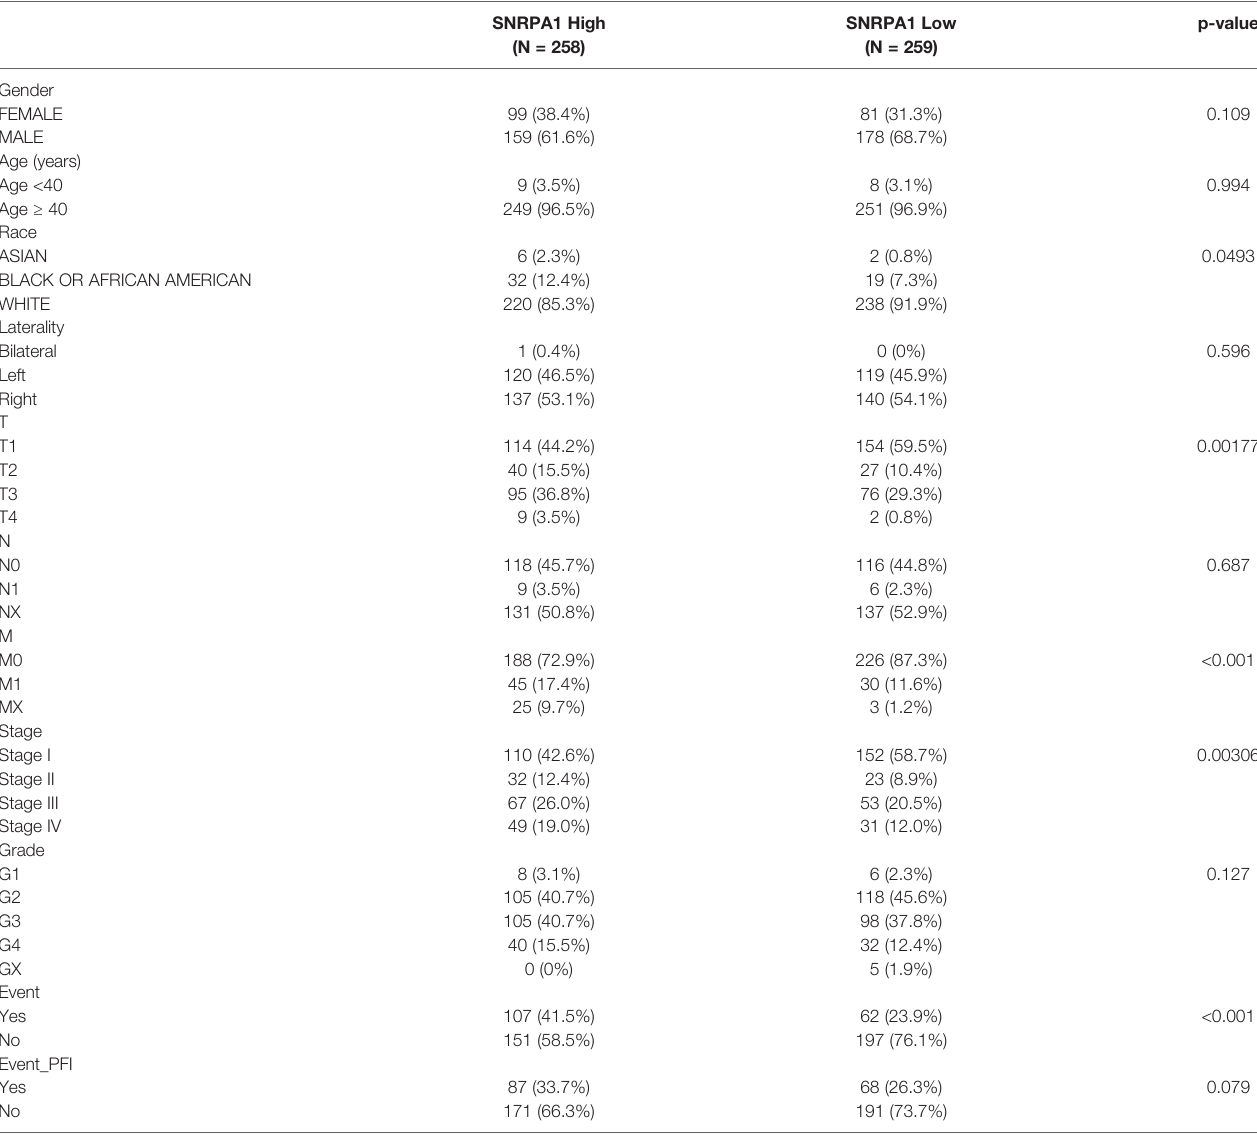
TABLE 1 | Clinical characteristics of SNRPA1 -high and -low expressed ccRCC